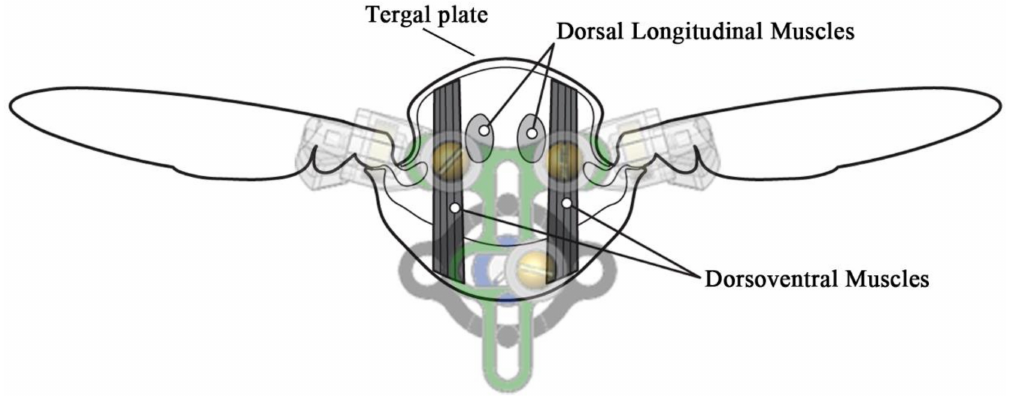
Figure 2. A cross section of an insect’s thorax depicting the indirect flight muscle system. Our latest flapping-wing mechanism is overlain, indicating similarities between the thorax and the mechanism. The Scotch-yoke of the mechanism encompasses both the dorsal longitudinal muscles (DLMs) and dorsoventral muscles (DVMs) as it drives the wings in both directions